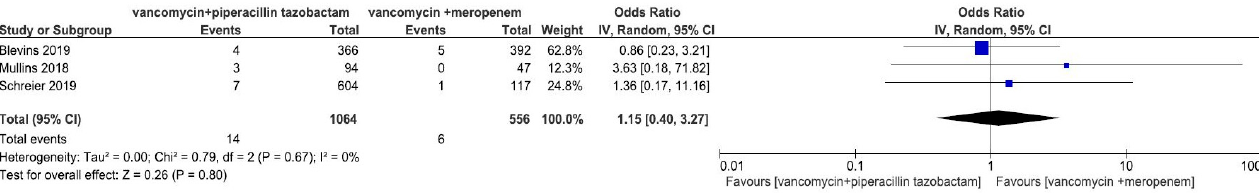
Figure 4. Renal replacement therapy (RRT).